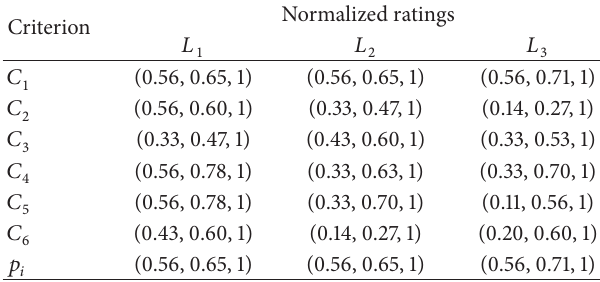
Table 10: The final fuzzy evaluation value for potential locations.